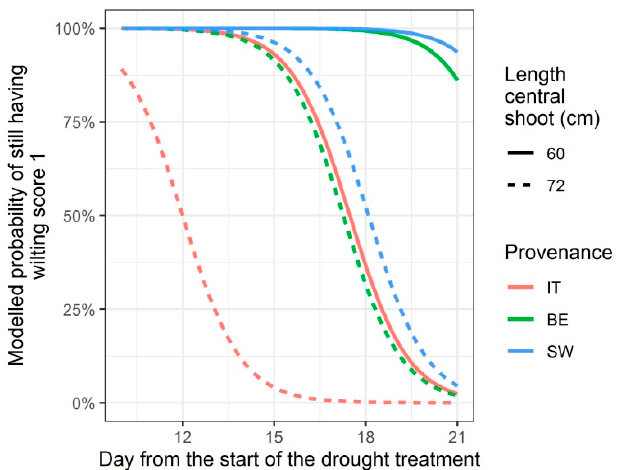
Figure 8. Modelled timing of leaf wilting for the drought treated plants, depending on the provenance and on the length of the central shoot at the start of the treatment. IT: Italian provenance, BE: Belgian provenance, SW: Swedish provenance.